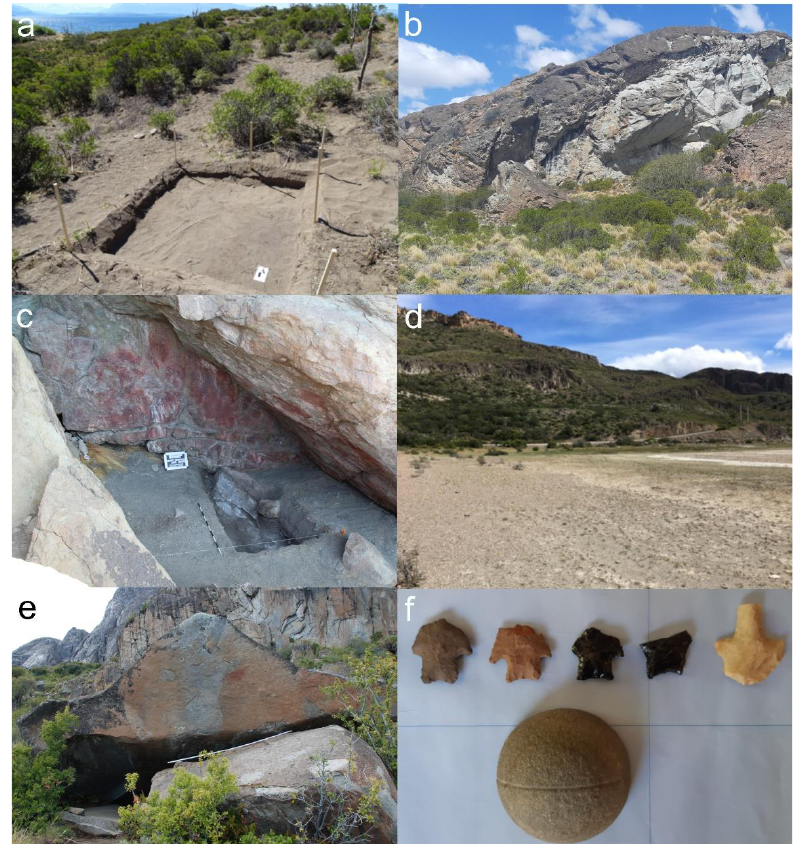
Figure 3. Site variability and the archaeological record along the southern coast of General Carrera Lake: ( a ) Chile Chico 1 site (RJ80); ( b ) Pampa La Perra (RJ97) site; ( c ) excavations at La Tina (RJ82) rock shelter; ( d )Laguna El Peligro (RJ81) site on the border of the dry lake; ( e ) Guanaca y Luna site (RJ146); ( f ) characteristic lithic material from surface scatters, including fractured projectile points (silex and obsidian), a borer, and a stone hunting bola.